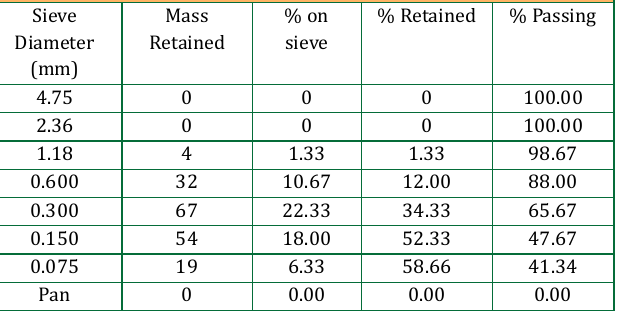
Table 4 (d): Particle Size Distribution Analysis for Point 4